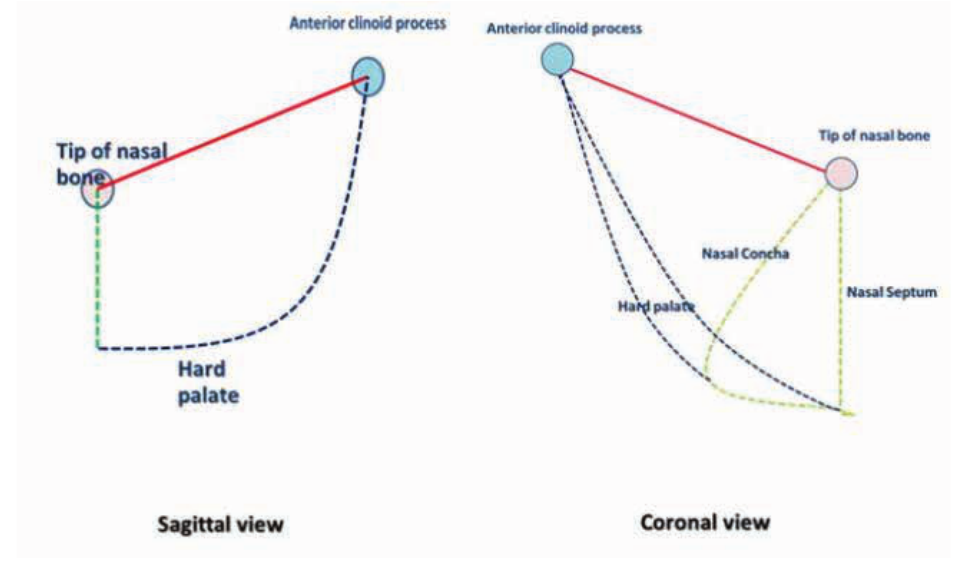
Figure 2: Diagram of nasal cavity